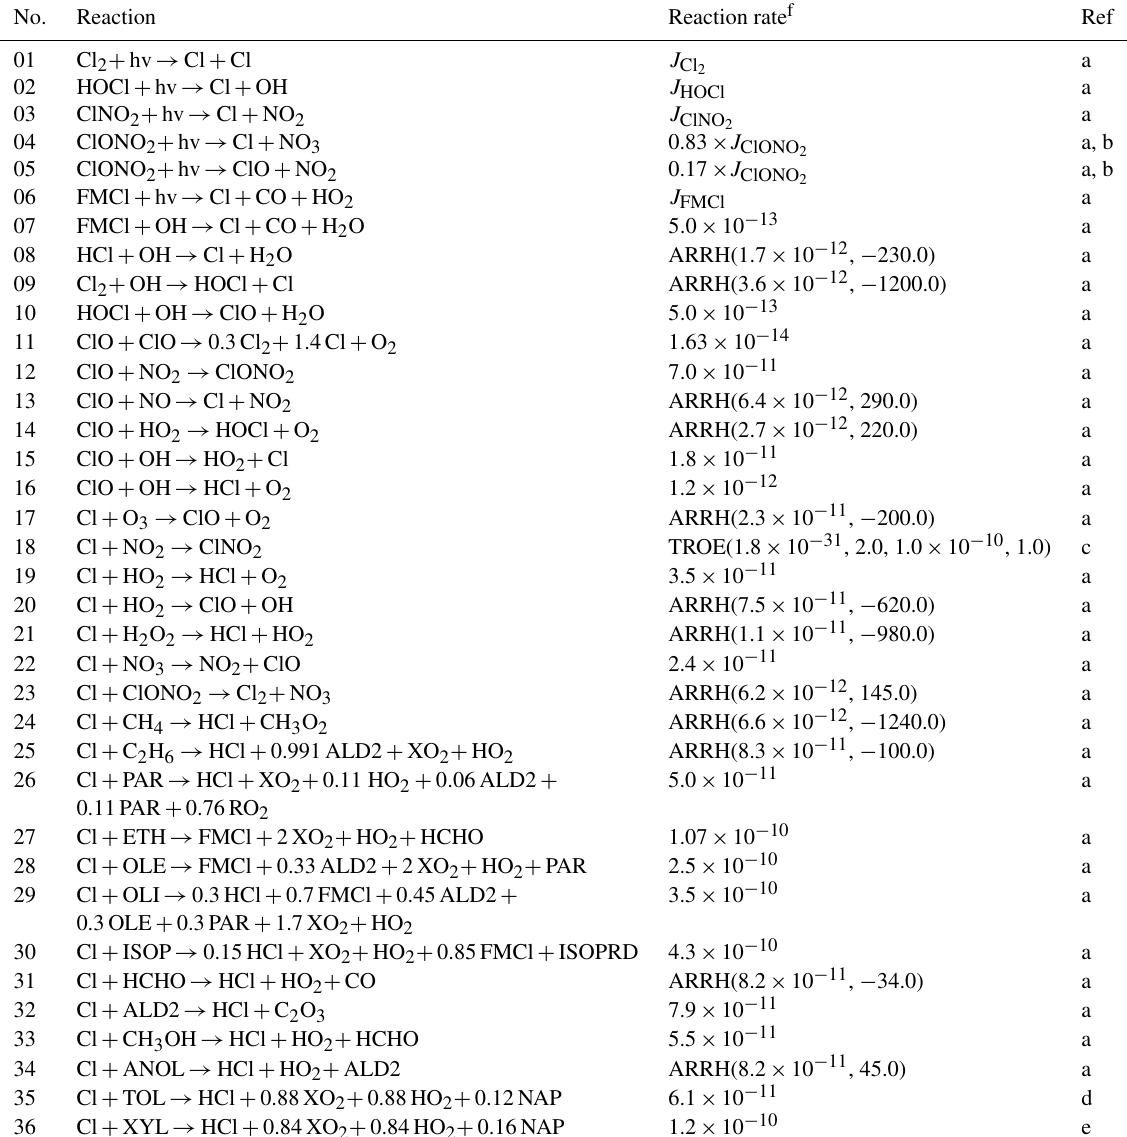
Table 1. Mechanism of chlorine chemistry in the CBMZ_ReNOM in WRF-Chem. No. Reaction Reaction rate f